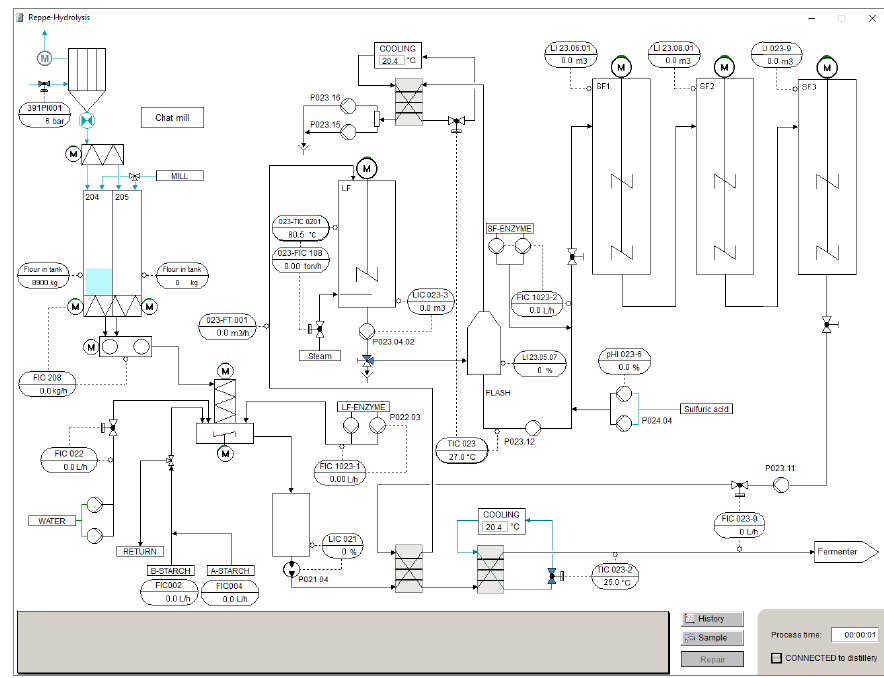
Figure 2. Graphical user interface of the pre-treatment and hydrolysis process unit of the OTS showing the tanks and instrumentation system in an initial and inactive mode. Controllers and pumps are linked with additional sub-windows where the trainee can change controller set points, adjust flow rates or start and stop pumps and motors. Alarm messages are shown in the grey box below (currently no message is shown). Process on-line data (e.g., pump capacities, volumes, temperatures) are shown in a separate sub-window (“ History ”). Sampling is initiated via another sub-window (“ Sample ”). The hydrolysis GUI (graphical user interface) is linked to the fermentation GUI (“ FERMENTER